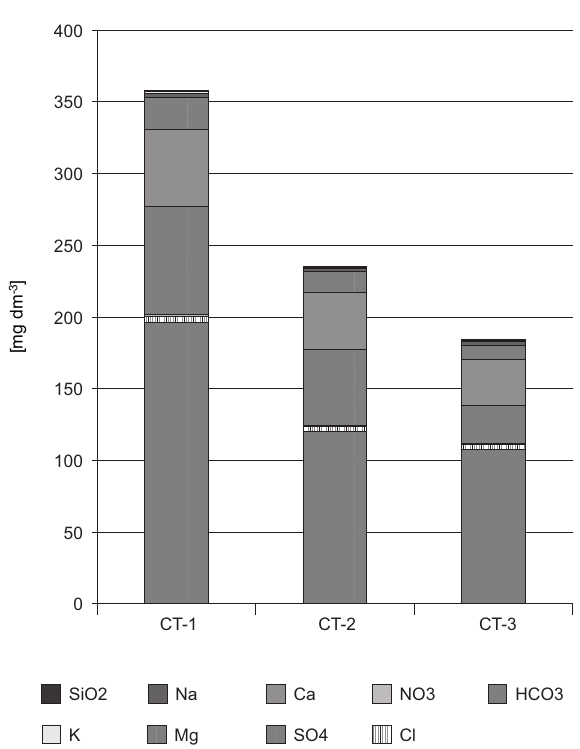
Fig. 7. Water ionic composition in streams leaving the study catchments: CT-1, CT-2 and CT-3; 6 August 2004